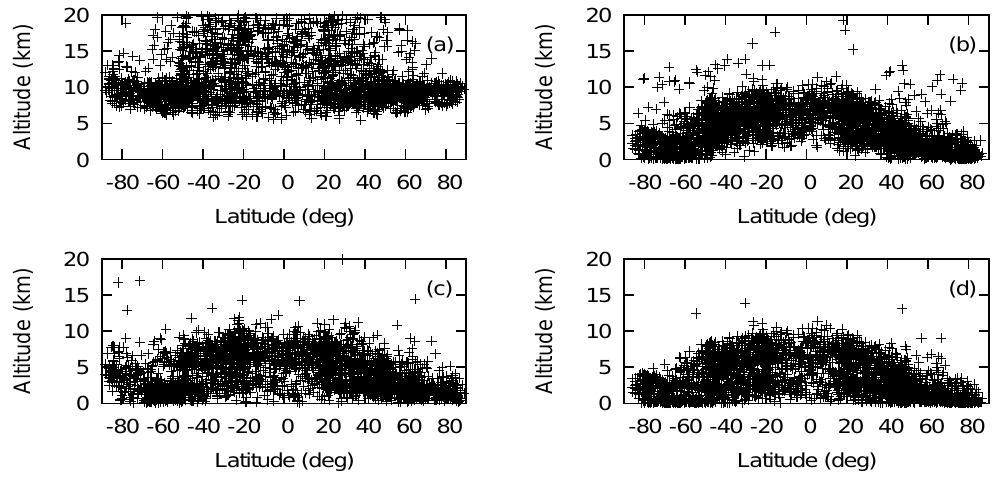
Fig. 4. Penetration depth of GRAS occultations for the first 10 days of December 2010, as a function of latitude. (a) Rising occultations with- out “L2 extrapolation”, (b) setting occultations without “L2 extrapolation”, (c) rising occultations including “L2 extrapolation”, (d) setting occultations including “L2